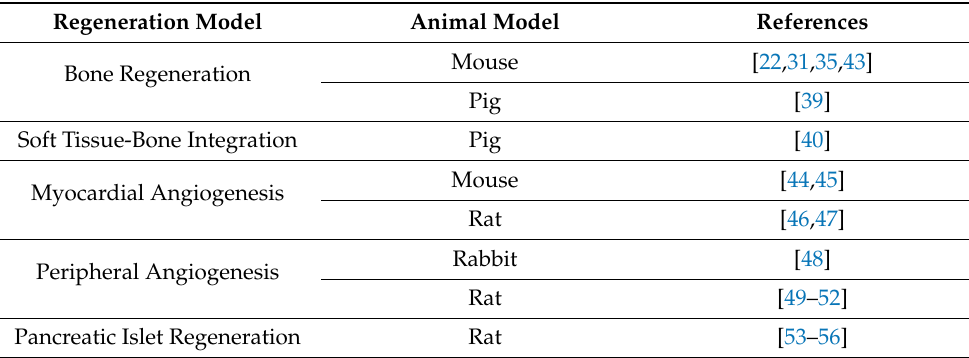
Table 2. The use of sonoporation for tissue regeneration. Regeneration